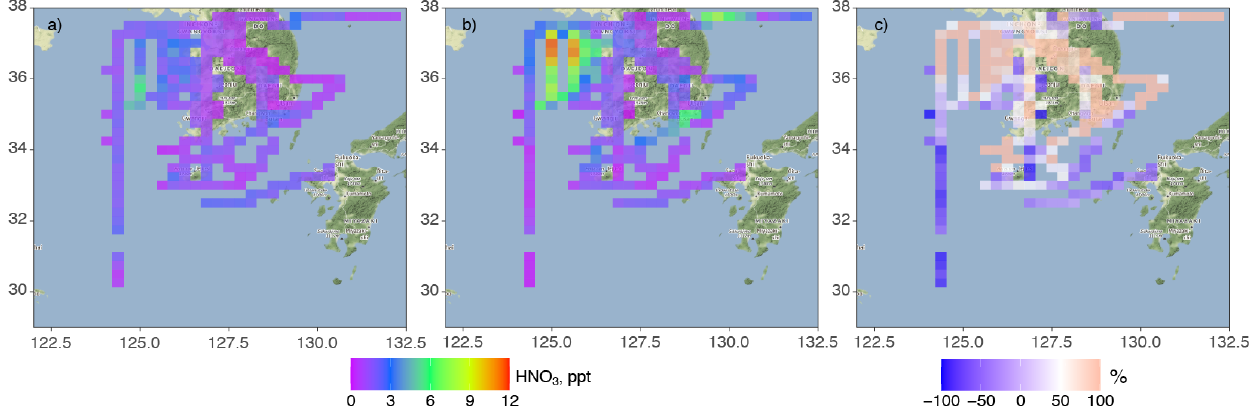
Figure 7. Gridded HNO 3 from the observations (a) , the model (b) , and the percent difference (c) along the flight tracks at the model resolution and below 2km. Map tiles by Stamen Design under CC BY 3.0. Data by ©OpenStreetMap contributors under